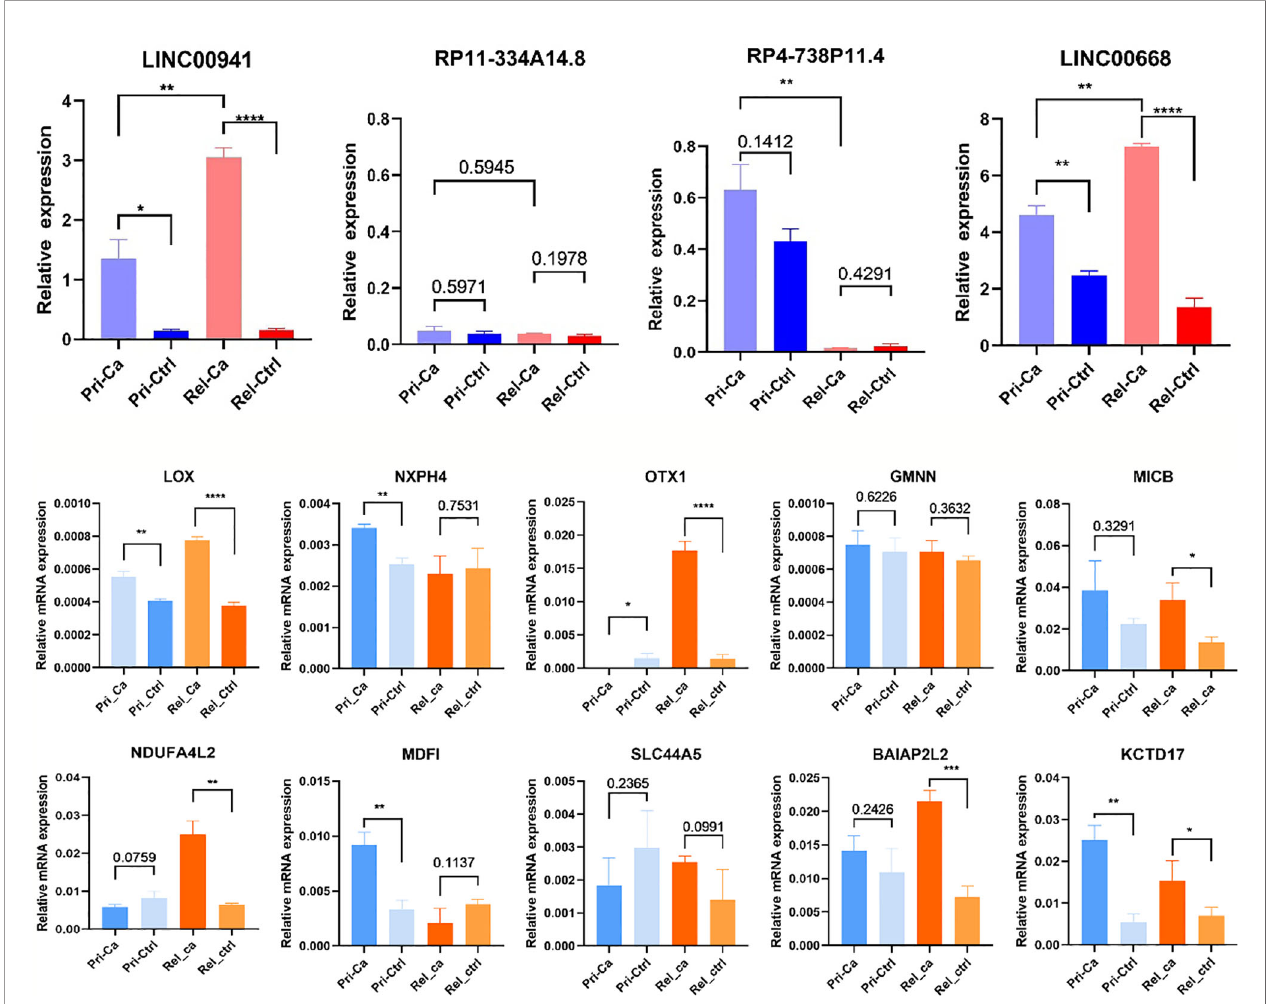
FIGURE 7 | Relative expression levels of lncRNAs and mRNAs in clinical samples. (*P < 0.05, **P < 0.01, ***P < 0.001, ****P <